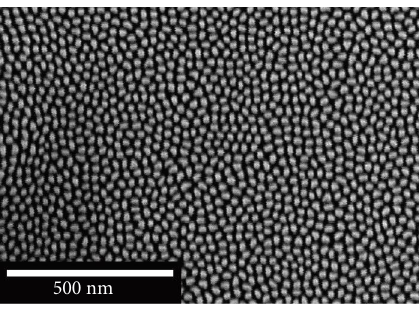
Figure 2: Scanning electron microscope (SEM) image of a “Brush Cut” morphology introduced during nonreactive ion etching (IE) of a GaSb wafer. Depending on etch time, the pillar (brush hair) height/width is quite